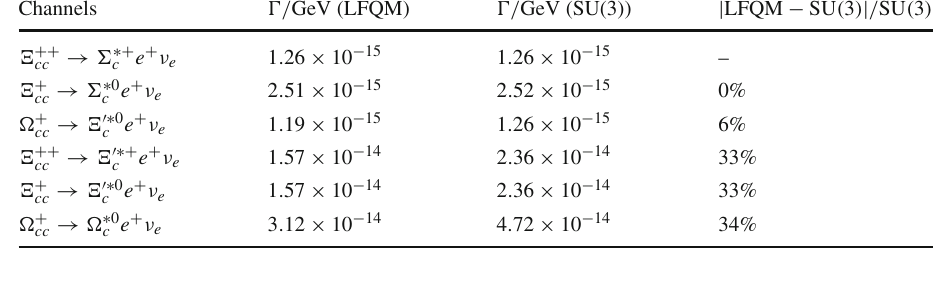
Table 23 Same as Table 22 but for the bb sector